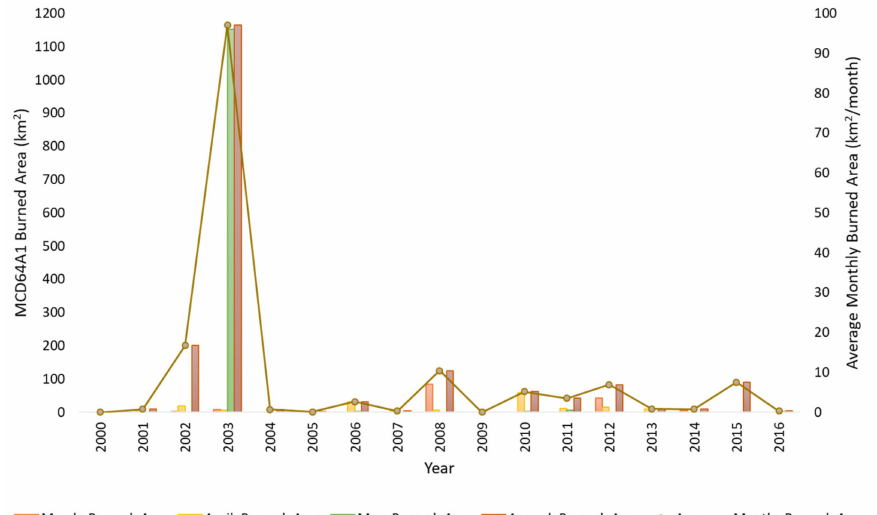
Figure 10. The burned area in the study area (March, April, May, and whole year only) obtained by the MCD64A1